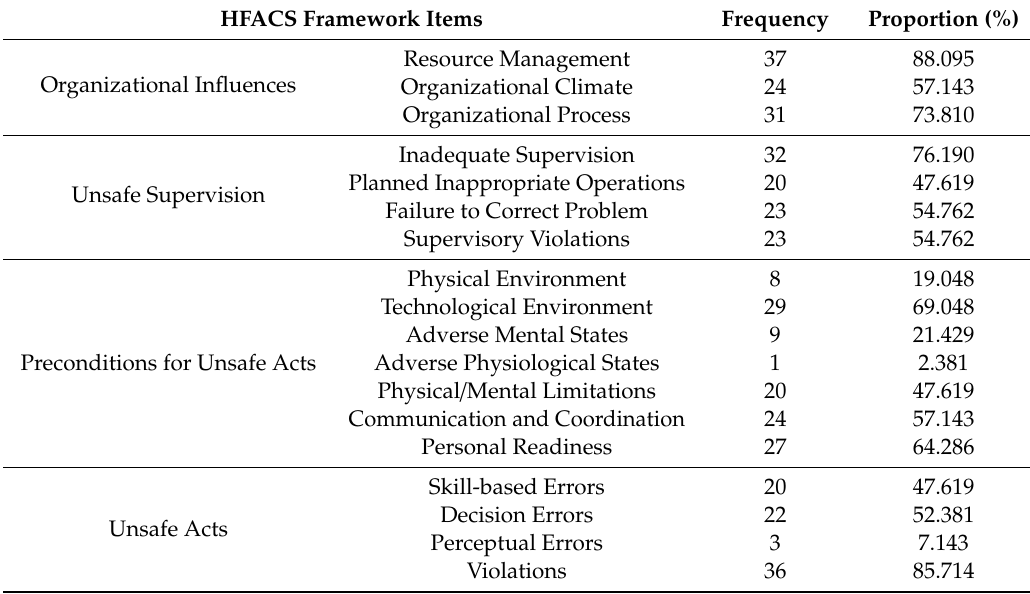
Table 4. Frequency and percentage of accident causes under the HFACS framework.